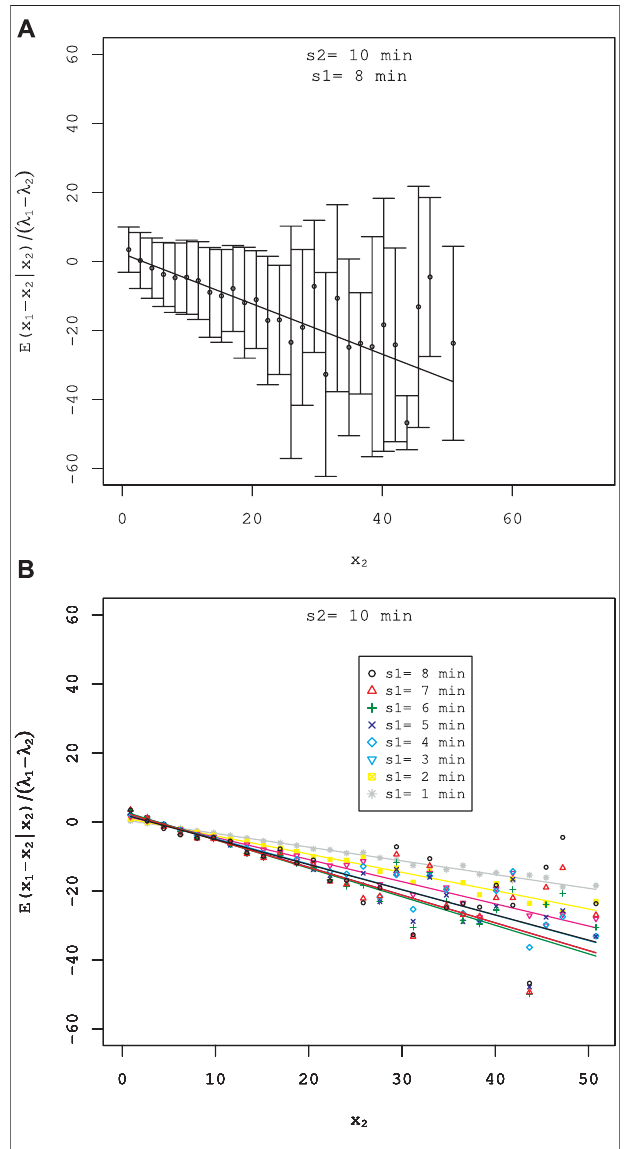
FIGURE 3 | Regression of E ( x 1 − x 2 | x 2 (cid:2) x ) / ( λ 1 − λ 2 ) . (A) The standard errors are denoted by an error bar. (B) Fitting is applied to various s 1 and s 2